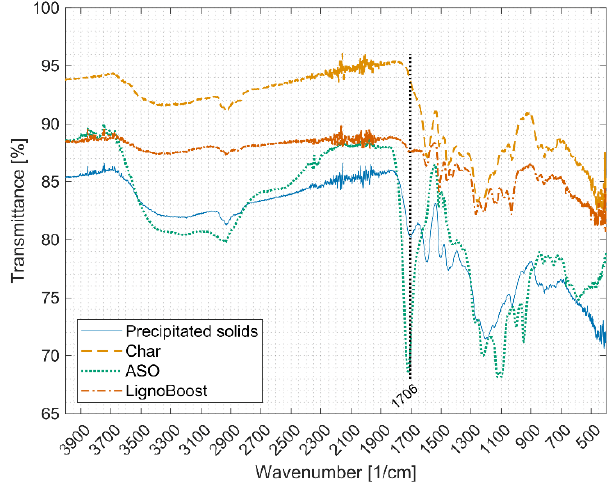
Figure 6. Typical attenuated total reflectance Fourier transform infrared spectroscopy (ATR-FTIR) spectra of the precipitated solids, char, ASO, and lignin. It can be noted that the char lacks the carboxyl peak at 1706cm −1 .